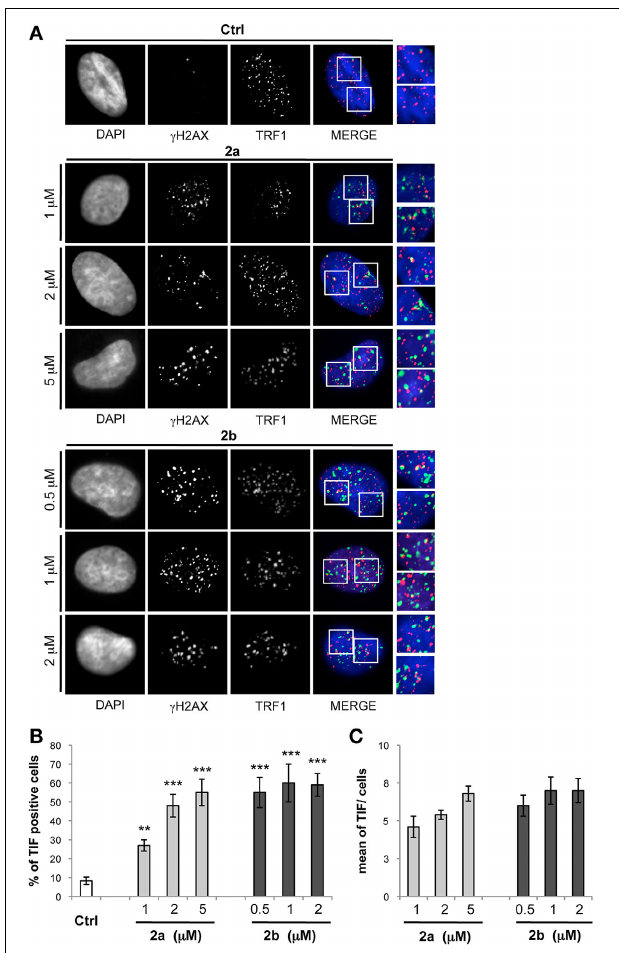
FIGURE 6 | Analysis of telomere damage by bis-indole derivatives 2a and 2b. BJ-EHLT fibroblasts were grown in absence ( − ) or in presence of the bis-indole derivatives 2a and 2b at the reported concentration. Upon 24h, each sample was processed for IF analysis by using antibodies against γ H2AX (green) and TRF1 (red) to mark DNA damage and telomeres, respectively. DAPI staining was used to mark nuclei. (A) Representative IF images acquired by using a Leica Deconvolution microscope (magnification 63 × ). Enlarged views of TIFs are reported on the right of each picture. (B,C) Quantification of TIF-positive cells (B) and mean of TIFs per nucleus (C) from IF experiments reported in (A) . Data are means ± SD of three independent experiments. p -values were calculated using the student t -test ( ∗∗ p < 0 . 005; ∗∗∗ p < 0 . 001).